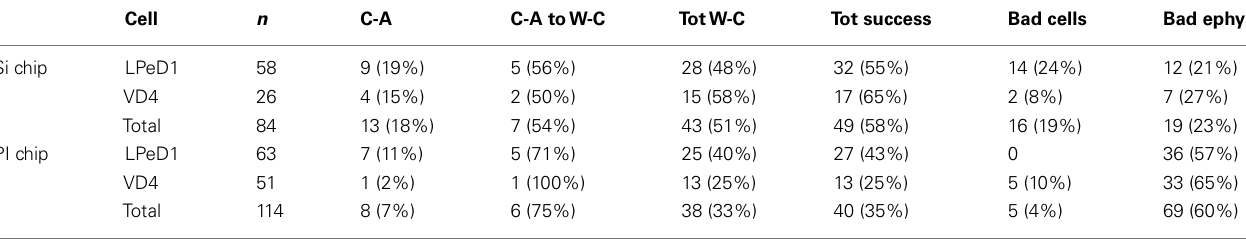
Table 1 | Summary of the experiments performed with Si and PI planar patch-clamp